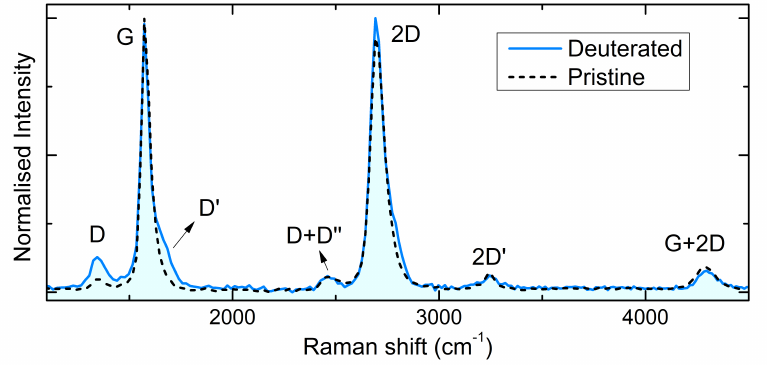
Figure 4. Raman spectrum of the deuterated NPG sample (blue line), acquired with a λ = 532.2 nm excitation laser. The Raman spectrum of the pristine sample (black dashed line) is shown for comparison, to emphasise the slight increases in the D and D’ peaks following the